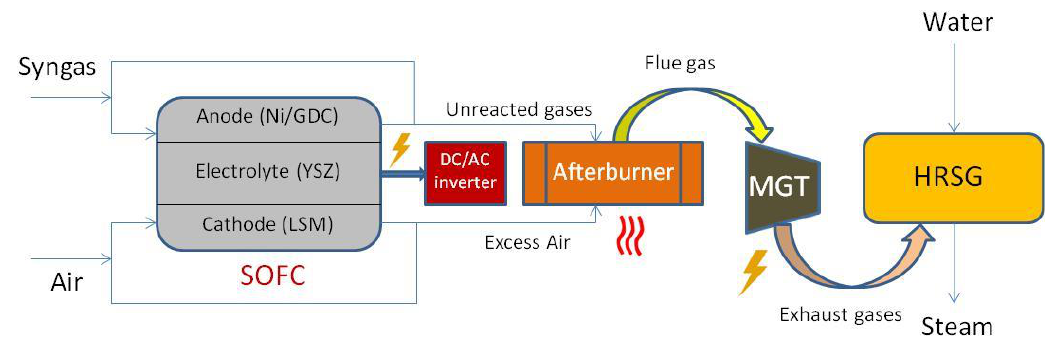
Figure 2. Scheme of a proposed system for combined SOFC–CHP (SOFC—solid oxide fuel cell; MGT—microgas turbine; HRSG—heat recovery steam generator).